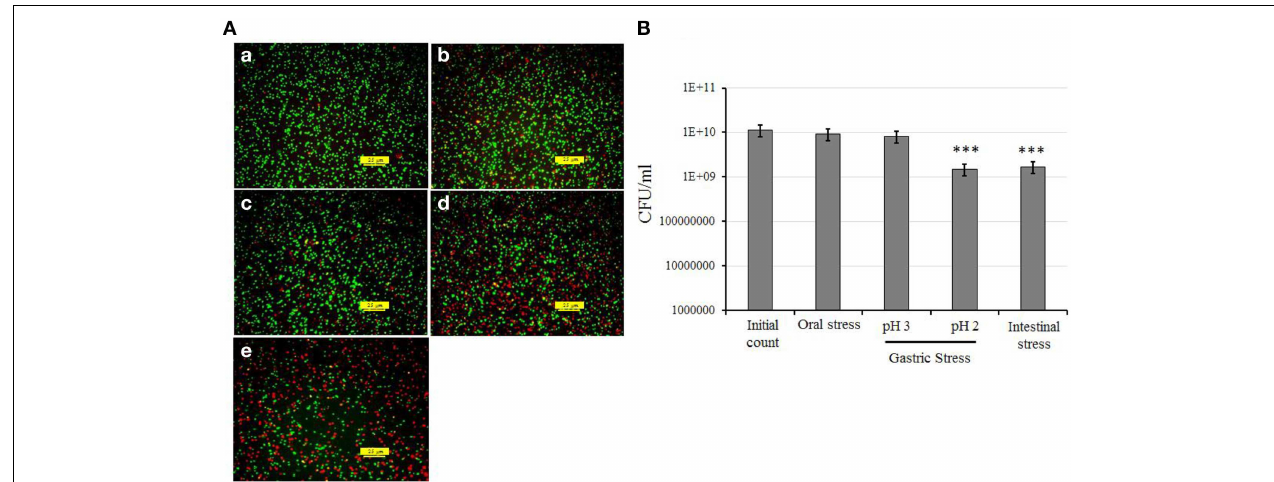
FIGURE 1 | In vitro assessment of oro-gastrointestinal transit tolerance of strain KID7 under simulated conditions. (A) Fluorescence photomicrograph of KID7 cells after various stages of simulated oro-gastrointestinal transit: (a) initial, (b) oral stress, (c) gastric stress pH 3, (d) gastric stress pH 2, and (e) intestinal stress. The live, and dead/damaged cells were identified by using the LIVE/DEAD BacLight bacterial viability kit after oral, gastric and intestinal stress